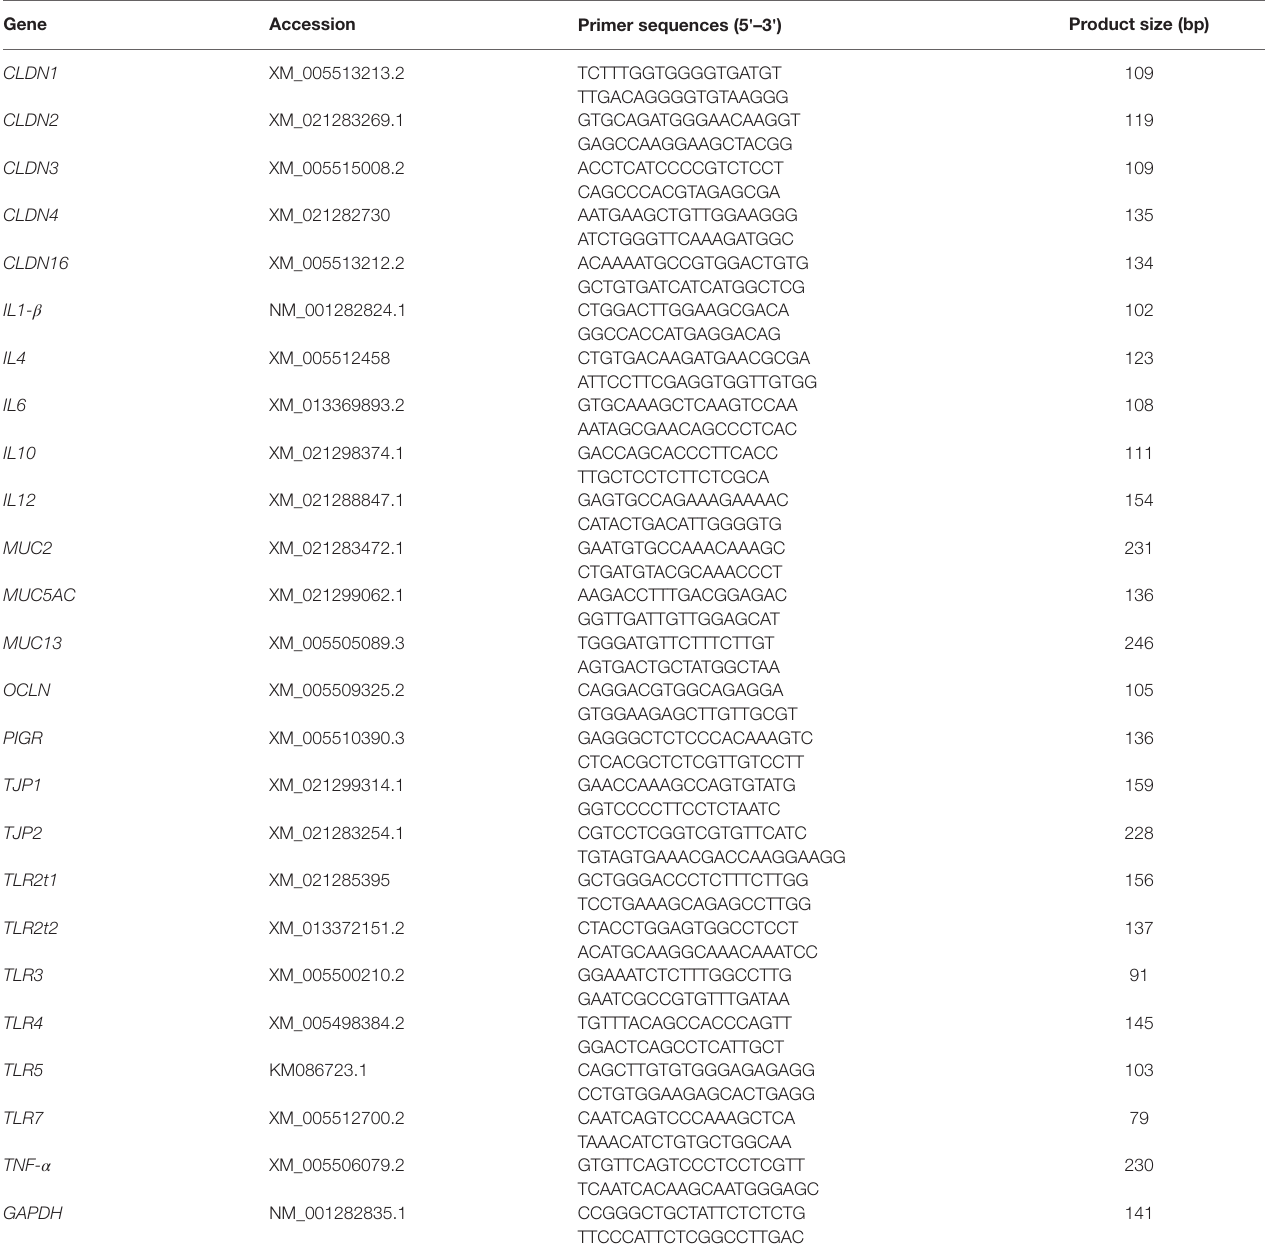
TABLE 1 | Gene-specific primers used for quantitative real-time PCR